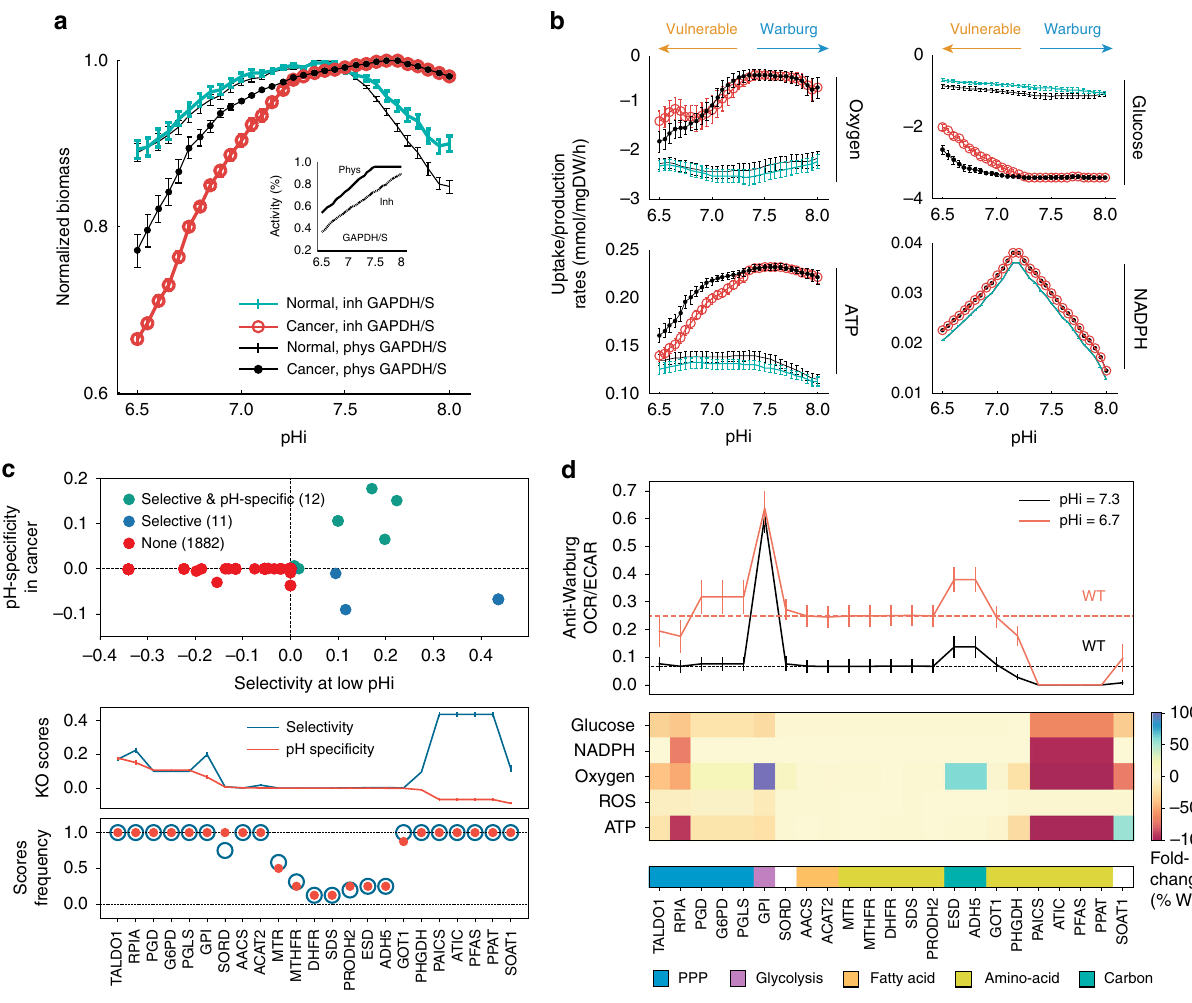
Fig. 2 In silico pH-dependent metabolism of cancer and normal cell models. a Cellular proliferation (biomass yield) as a function of pHi, normalized by the maximal value obtained across all pHi examined, of cancer (circles) and normal healthy (solid) cells, when GAPDH is at physiological levels (black) and when it is inhibited (color), as depicted in the inset. b Uptake/production rates of oxygen, glucose, total ATP, and total NADPH. Uptake rates are conventionally depicted with a negative sign (more negative values denote higher rates). Error bars depict the standard deviation of the mean values across the populations of GSMMs at each pHi. c Anti-proliferative effects of gene inhibition (knockout), showing the classi fi cation of knockouts according to their selectivity and pH-speci fi city scores (top). The predicted targets, ranked by their pH-speci fi city, with the average selectivity scores superimposed (middle), as well as frequency of scores across all pair comparisons ( ≥ 12.5%) are shown (bottom). d The anti-Warburg scores (OCR/ECAR) of knockouts at low and physiological pHi (top), and the changes in the uptake/production rates of key metabolites, relative to the wild type (WT) at low pHi (bottom), are shown for each target. Pathways associated with each target are shown in color code. Results are robust with respect to choice of model parameters (Methods and Supplementary Figures 8 – score (SEL), 1839 have zero pH-speci fi city score (PHS), and the rest have negative scores). The frequency of scores across all